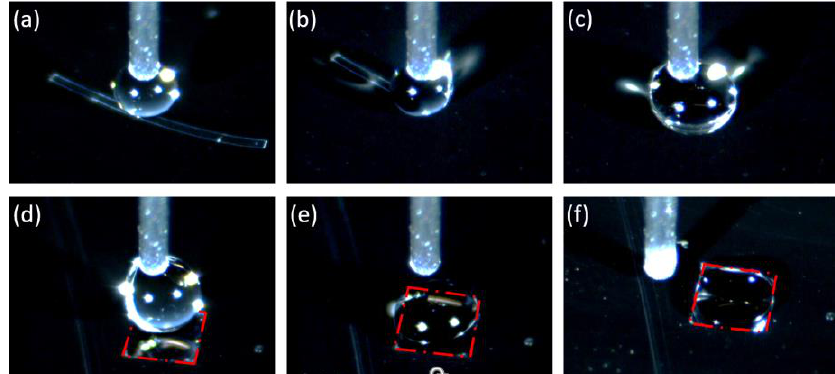
Figure 9. Elasto-capillary transport of miniature elastic ribbon. ( a ) a droplet is produced with a needle; ( b ) the needle with the droplet picks up the ribbon; ( c , d ) the ribbon bends and is transported to the hydrophilic site; ( e , f ) the droplet is in contact with the hydrophilic site and the ribbon is released on the target. The images are snapshots from the Supplementary Video S1.